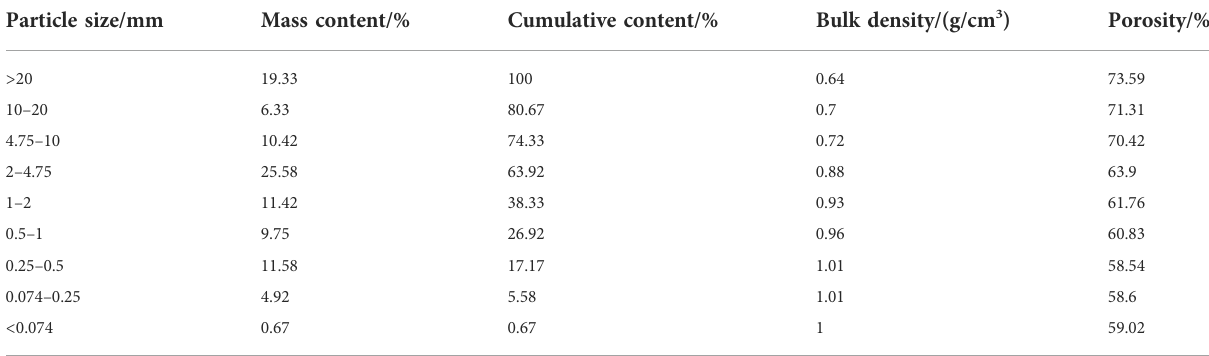
TABLE 1 Jintan insoluble particle distribution table.